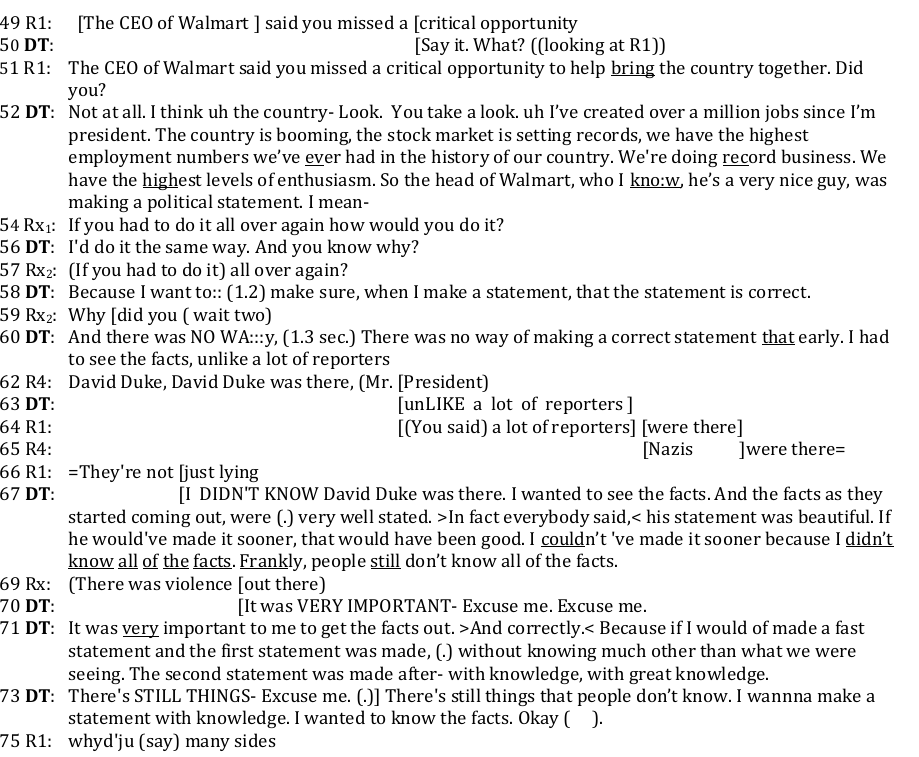
Figure 7. Transcript excerpt 49–75.